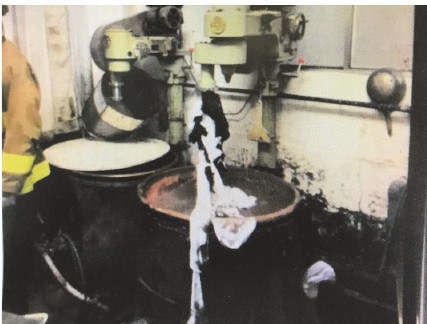
Figure 1: The scene of the accident. The patient’s clothing was entrapped and wound around the mixing rotator.